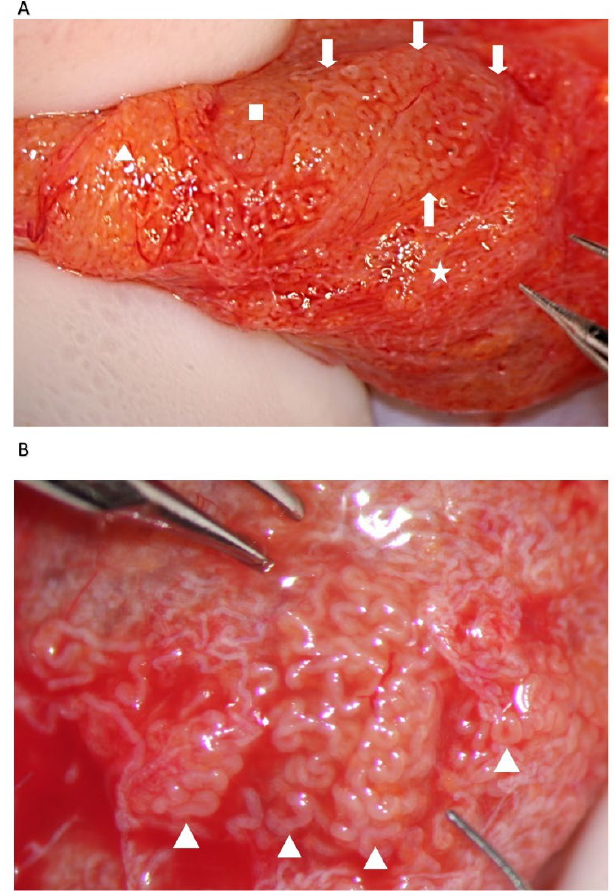
Figure 10. ( A ) Each lobule is made up of tubules of the same caliber, but the caliber decreases from lobule to lobule: dilated (delimited with arrows), less dilated (triangle), narrow (square), and atrophic (star); ( B ) four lobules of dilated tubules emerging from atrophic parenchyma. At the end of the exploration of the testicular parenchyma at high magnification, the testicular tissue surface is irrigated for antisepsis with Ringer solution (with 80 mg gentamycin/100 mL). Hemostasis is performed when the blood pressure is normalized to avoid postoperative bleeding by gently pressing the testicular tissue for 4 min using gauze wet with the antiseptic solution and eventually (the least possible) using the